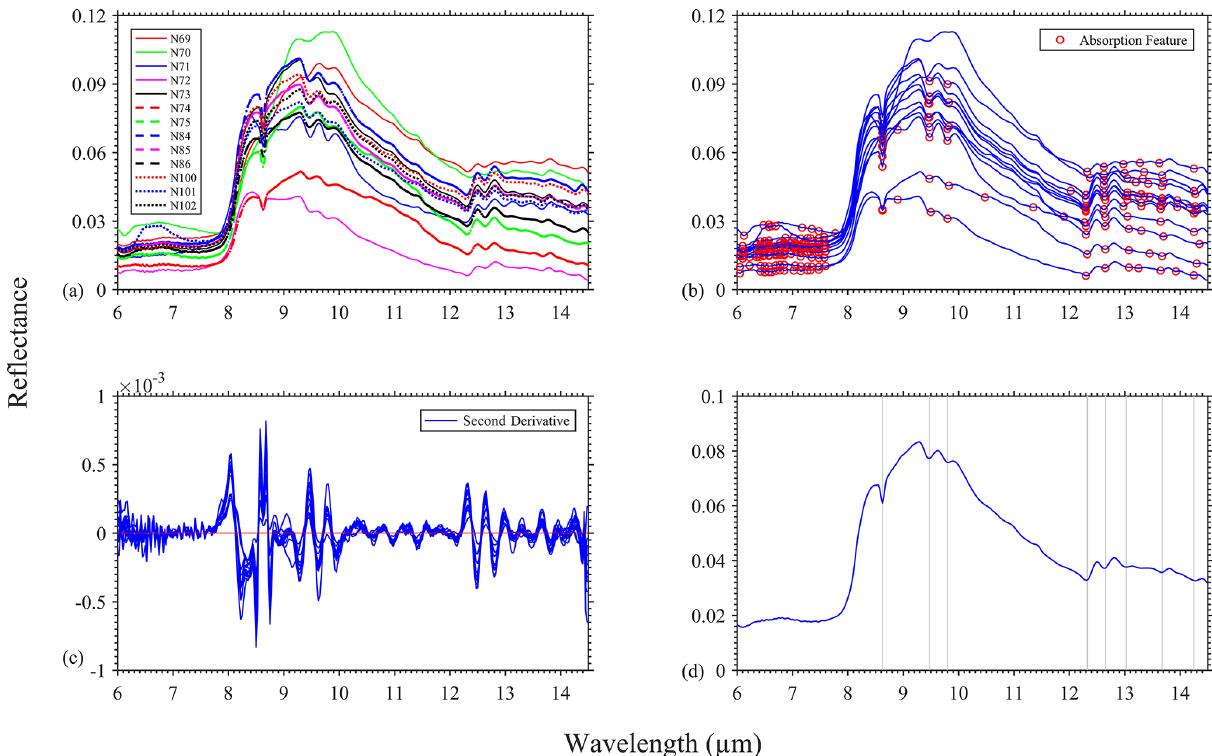
Figure 2. (a) Spectral reflectance of sands gathered along the shorelines of Punta Mallil-Cuem, Detif and Punta Apabón on the Chiloé Archipelago, Chile; (b) absorption features automatically picked; (c) second-derivative spectra; and (d) an end-member signal with the proposed diagnostic absorption features highlighted by the vertical